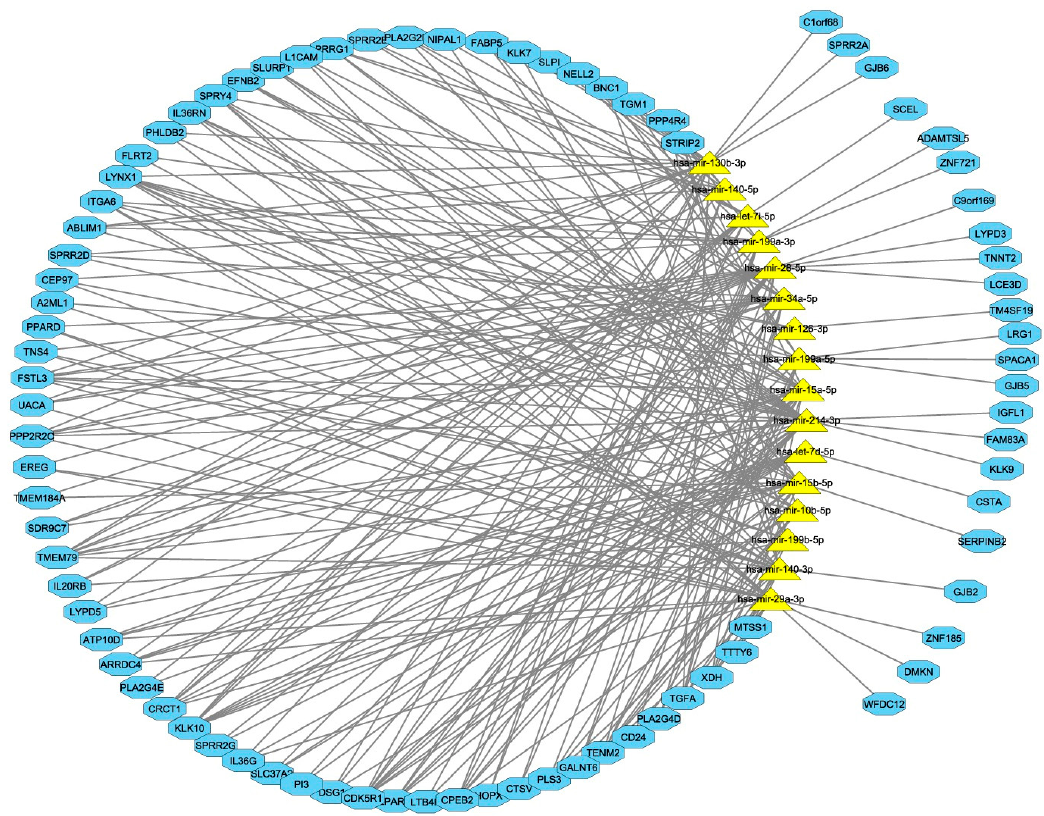
Figure 4. Computational integration of genes and miRNAs by MAGIA2 bioinformatics tool: The network of anticorrelated miRNA genes was computed by rCCA and integrated by MAGIA2 tools with the information of target prediction derived from DIANA-microT, TargetScan, and microrna.org. Two hundred and forty-five interactions were found among 16 miRNAs and 84 genes. The Cytoscape tool was applied to display the interconnections between features. Yellow triangles indicate the miRNAs, and blue boxes indicate the genes. If it is predicted that a gene is to be targeted by at least two out of 16 miRNAs, this gene is located in the central ring, comprising the miRNAs. Otherwise, it is placed outside.